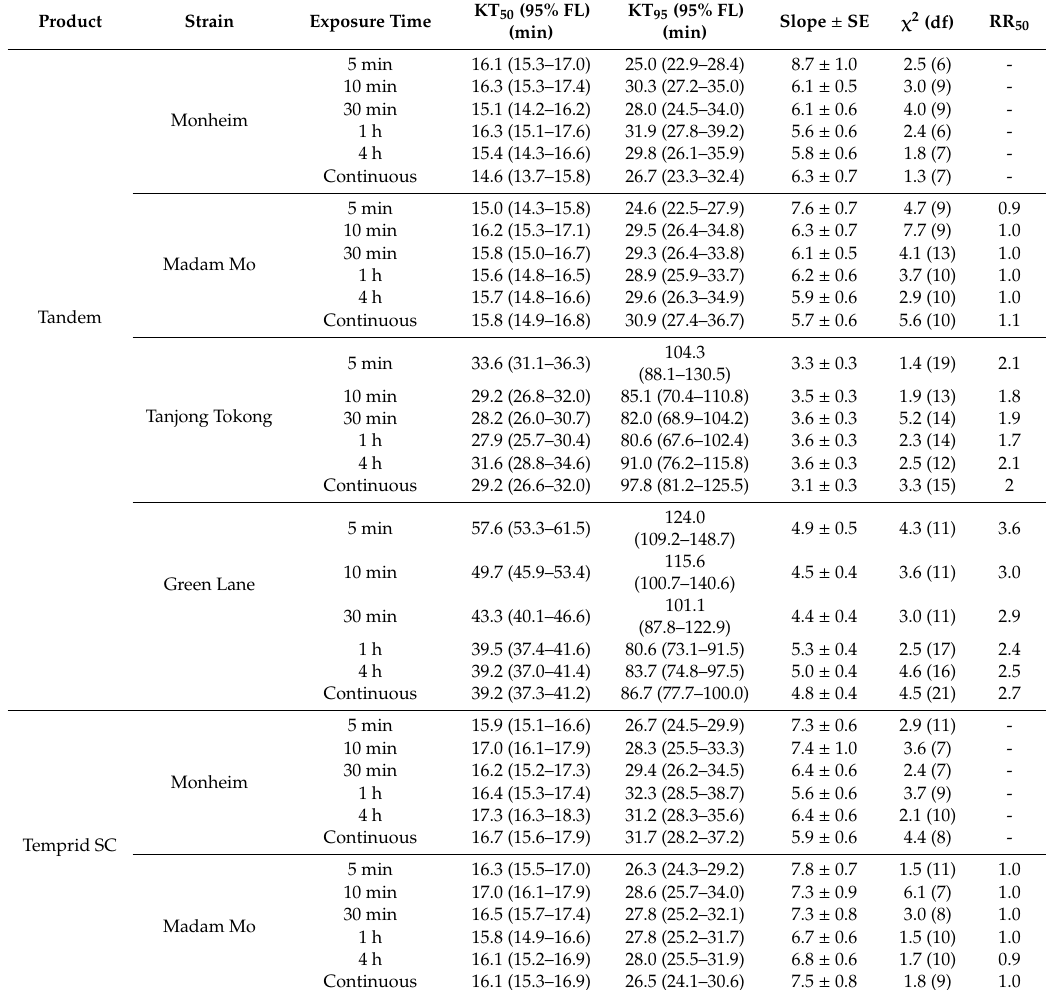
Table 4. The KT 50 and KT 95 values of a susceptible Cimex lectularius strain and three Cimex hemipterus field strains tested using five insecticidal products (Tandem, Temprid SC, Pesguard FG161, Sumithrin, and Sumithion) applied at label